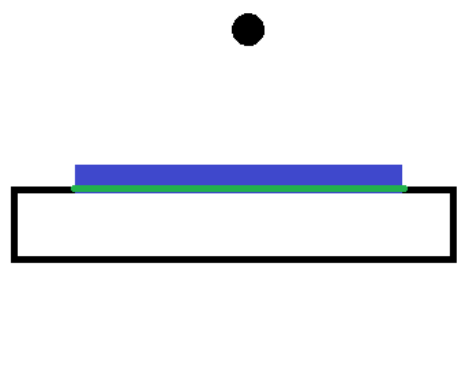
Figure 2. Simple detector model in MCNP (detector – black rectangle, electrode – green, conversion layer – blue, neutron source – black dot)